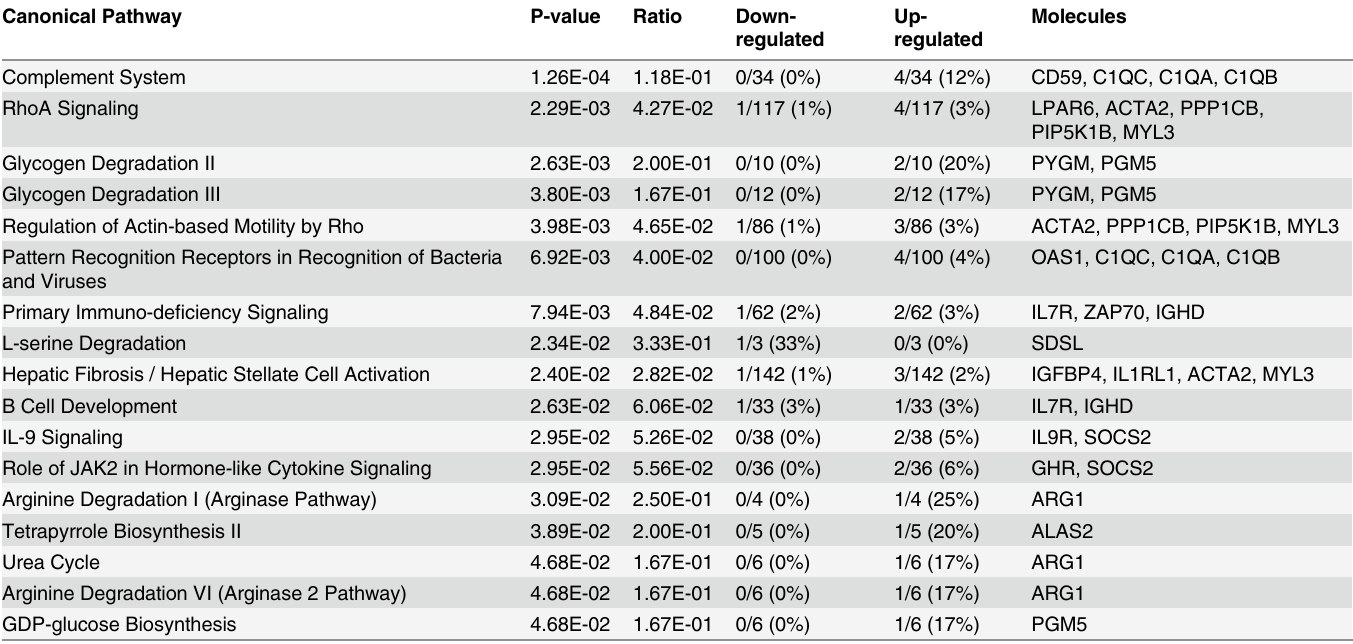
Functional enrichment pathway analysis for the set of genes differentially regulated by vaccination was determined using IPA software. Statistical signi fi cance: (p < 0.05). The ratio provides the proportion of genes in the respective canonical pathway, which are signi fi cantly differentially expressed after vaccination, relative to all genes present in the pathway. The proportion of upregulated and downregulated genes in the respective pathway and a full list of differentially expressed genes (molecules) assigned to the pathway are